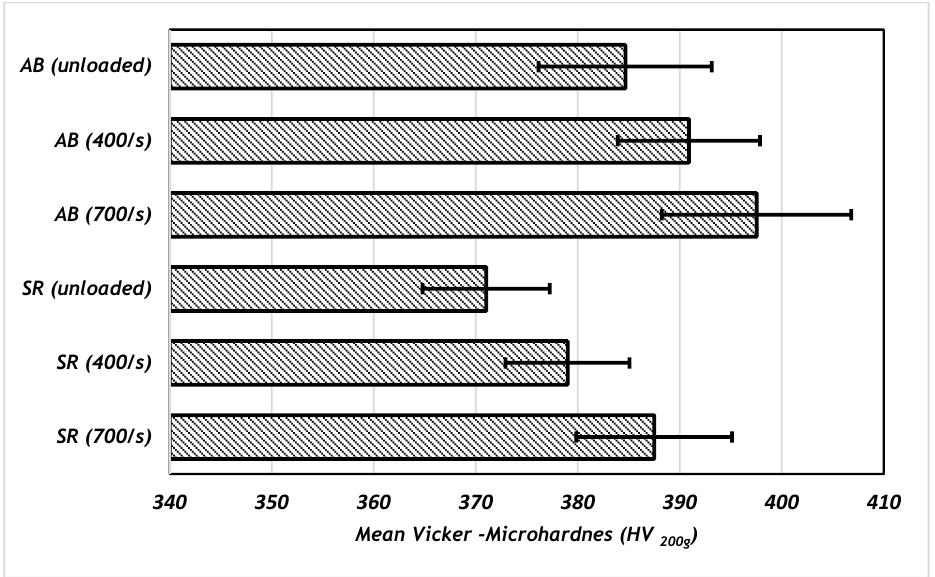
Figure 9. The values of mean Vickers microhardness for DMLS Ti6Al4V (ELI) for different load conditions in HV 200g .